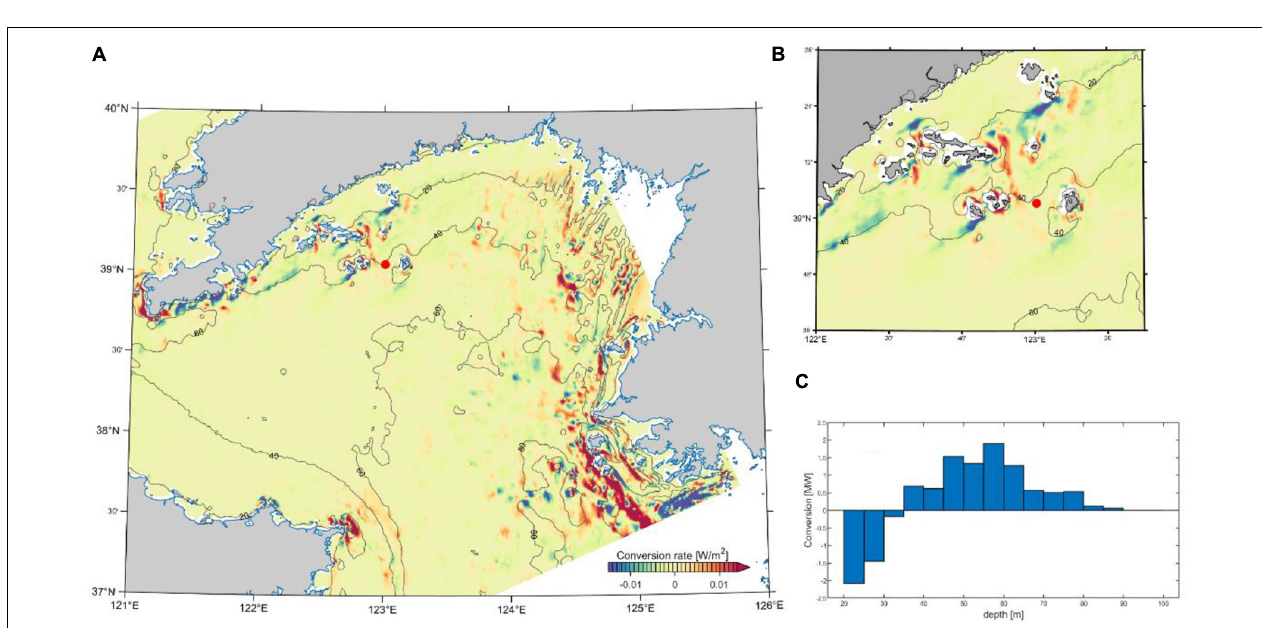
FIGURE 11 | (A) Depth integrated and period averaged barotropic to baroclinic energy conversion (W/m 2 ) in the northern Yellow Sea. Results were computed for the results from July 26 to August 10 in 2017. (B) The detailed conversion rate near the ADCP mooring site (red dot). (C) Mean conversion rate for binned depths within the domain in (A) . Solid lines represent the isobath contour of 20, 40, 60, and 80 m.